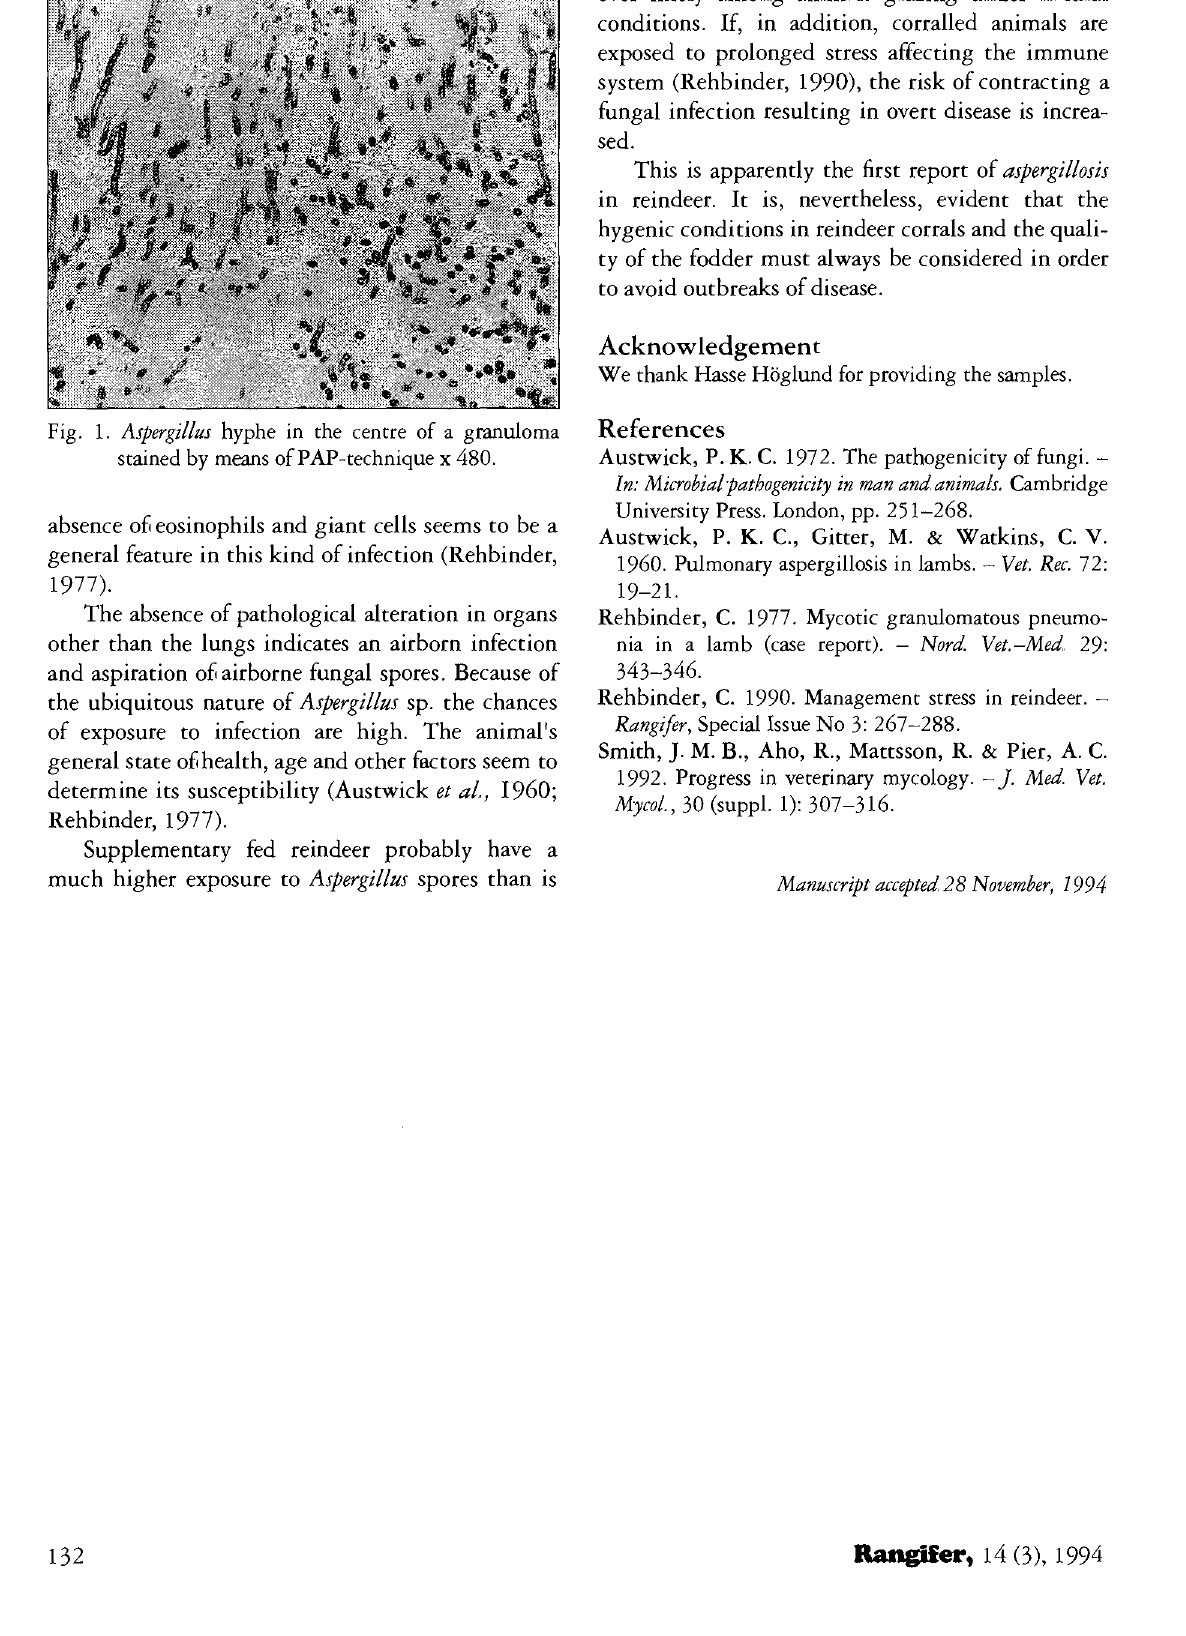
Fig. 1. Aspergillus hyphe in the centre of a granuloma stained by means of PAP-technique x